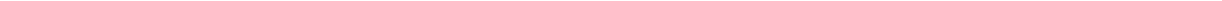
Figure 3 A pool of myosin undergoes ef fl ux from the contractile ring and enriches the daughter cell cortices during cytokinesis. a Sagittal view of a cell with NC expressing Sqh::GFP. Half of the cell cortex is presented at the time of myosin ef fl ux initiation (Time 0:00). The red arrowheads indicate the edge of the myosin signal propagating in the nascent Nb cortex. Myosin reaches the Nb pole within 2 min. See Supplementary Movie 2. b Kymograph of cortical myosin of the cell presented in a showing Sqh::GFP dynamics from one pole to the other as described in Fig. 2b and method section. The x and y axes scale bars indicate 6 s and 2 µ m, respectively. The red , brown , and black vertical bars designate the regions where the mean gray intensity of the myosin signal is measured and plotted in c . c Graph showing the mean gray intensity of myosin in three regions (adjacent to the contractile ring ( red ), lateral ( brown ), and polar ( black )) of the Nb cortex over time. Time = 0 corresponds to the time of myosin ef fl ux initiation. d Surface view of a sqh::GFP labeled cell with NC showing the contractile ring (CR, orange vertical bar ) and the regions adjacent to the ring (adj, red vertical bars ) at the time of myosin ef fl ux initiation. The last image is a sagittal view of the same cell at 1 min25s. The red arrow represents the region used for the kymograph in e . The green and magenta rectangles correspond to the insets below. The insets show the overlay of two time points of 10 s interval (early time point in green , late time point in magenta ). Blue arrows represent the displacement of some myosin patches within 10 s. e Kymograph of the cell shown in d . Patches of myosin move out of the contractile ring (CR, orange vertical bar ) and diffuse along the region adjacent to the ring ( red vertical bar ) toward the pole. The x and y axes scale bars correspond to 5 s and 5 µ m, respectively. f Time lapse of a cell with NC expressing Sqh::Dendra2. Dendra2 undergoes green to red photoconversion upon absorption of 405 nm light. No signal is detected with a 561 nm excitation wavelength before photoconversion. The red rectangle corresponds to the area photoconverted with the 405 nm laser. Upon irradiation at the site of the contractile ring (time 0:00), the pool of photoconverted Sqh::Dendra2 is rapidly visible with the 561 nm laser ( green arrow ). Two minutes after irradiation, the pool of photoconverted Sqh::Dendra2 is detected around the cortex similar to the Sqh::Dendra2 detected with the 491 nm laser. Time = min:s . Scale bars = 5 µ